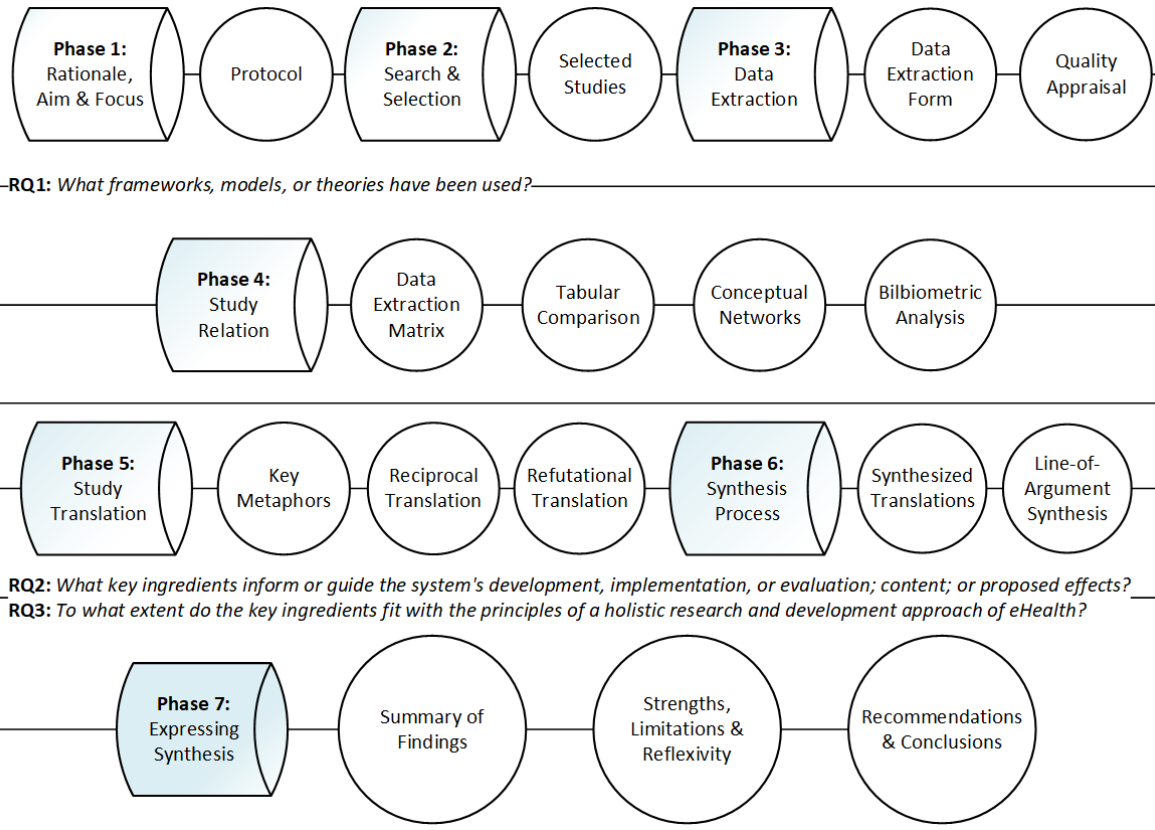
Figure 1. Phases and key output of the metaethnography review. RQ: research